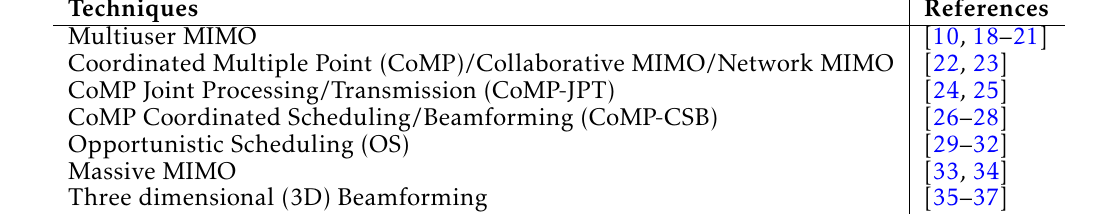
Table 1. Key Enabling Techniques for Future SDMA-based Wireless Networks